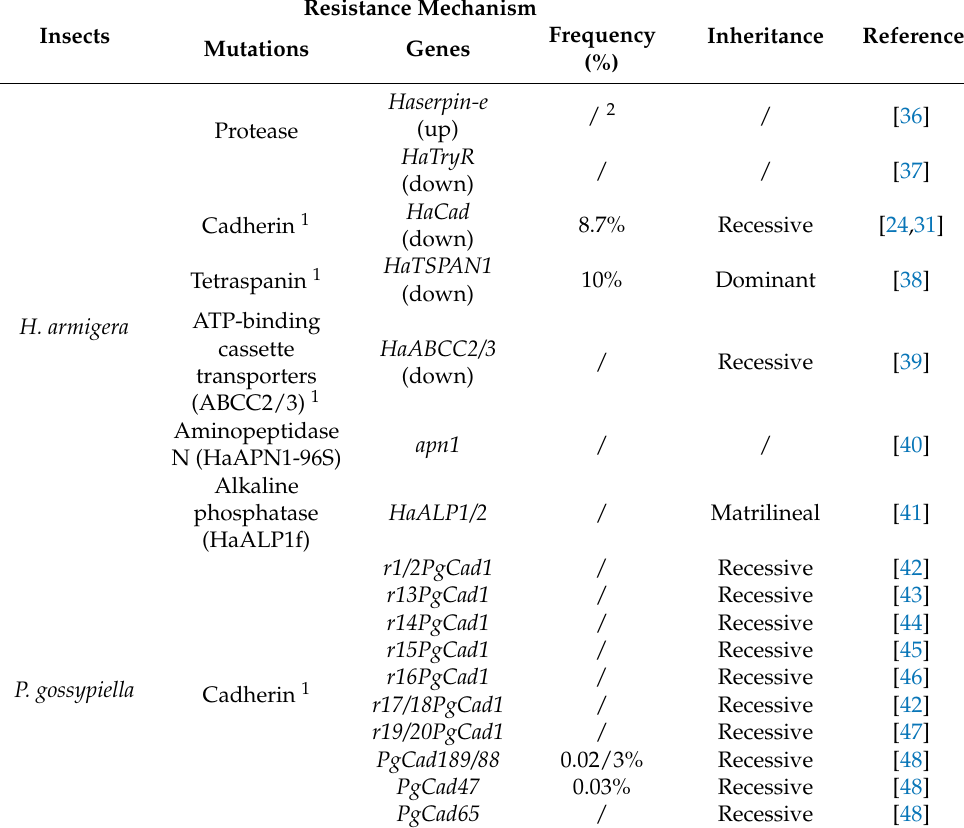
Table 1. The reported resistance mechanism of H. armigera and P. gossypiella in previous publications in